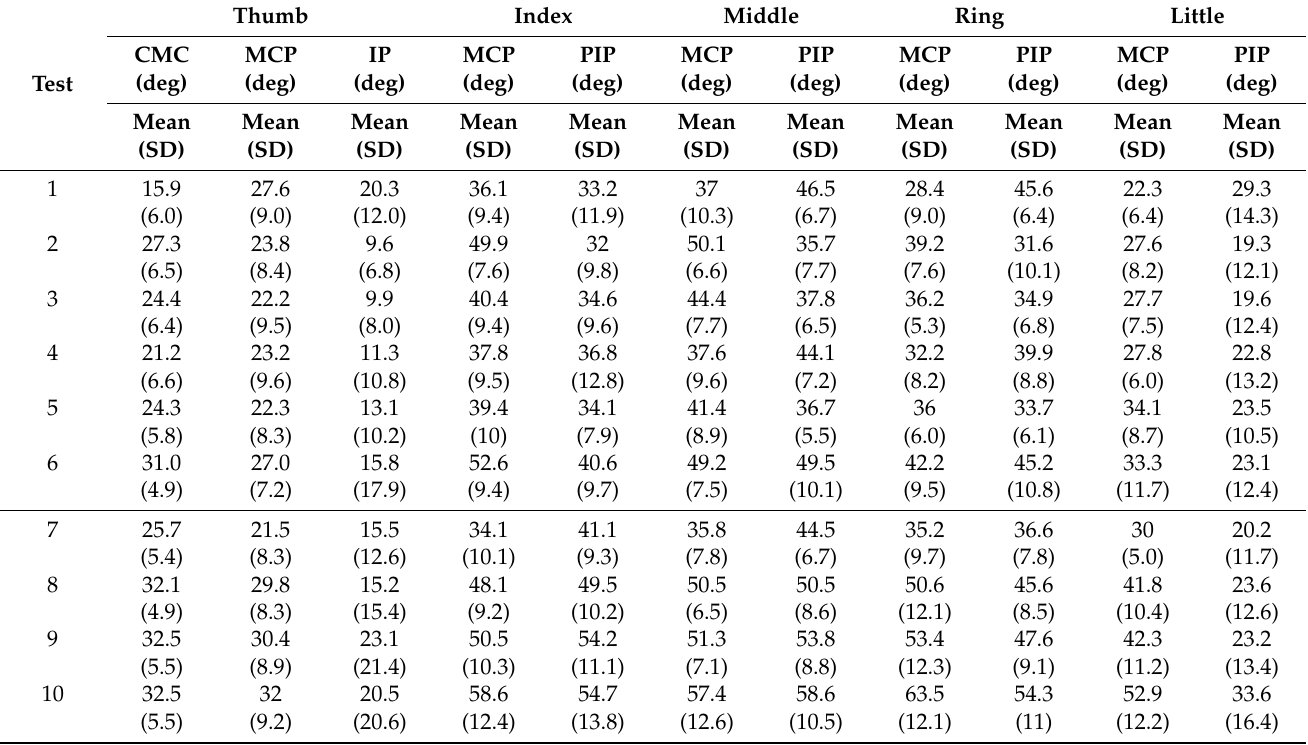
Table 3. Descriptive statistics of flexion angles required to perform ARAT